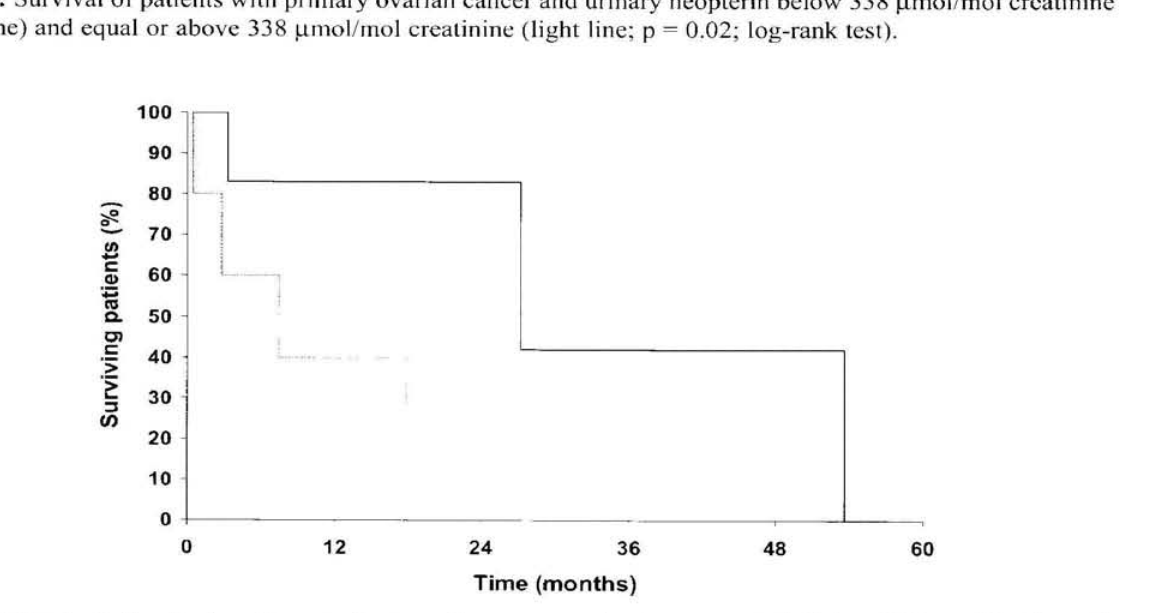
Figure 5. Survival of patients with secondary ovarian cancer and urinary neopterin below 338 pmol/mol creati- nine (black line) and equal or above 338 pmol/mol creatinine (light line; ρ = 0.05; log-rank test).